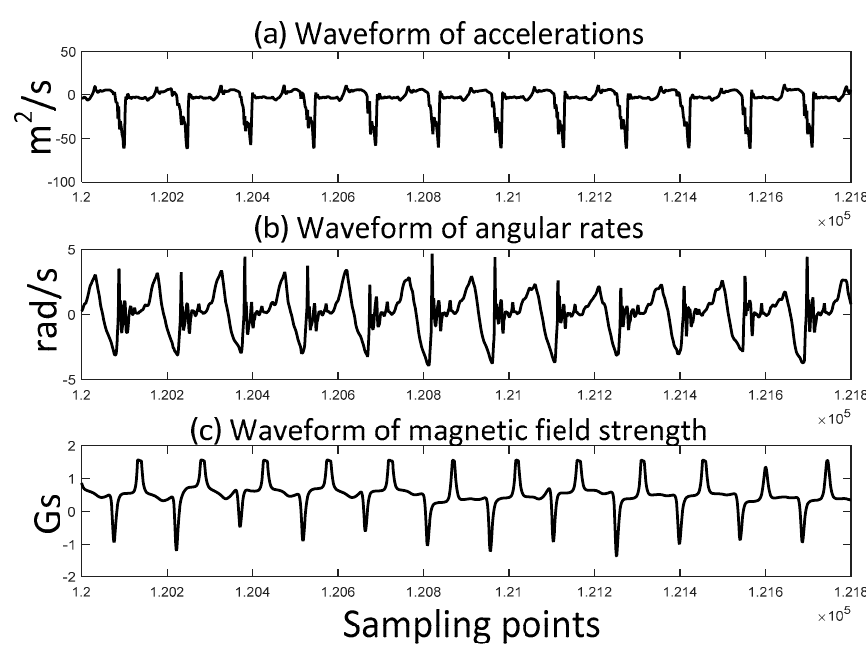
Figure 8. Waveforms of accelerations, angular rates and magnetic field strength during the same time period of running gait pattern.